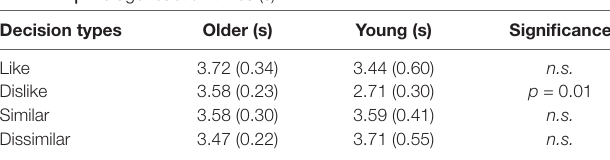
TABLE 1 | Average reaction times